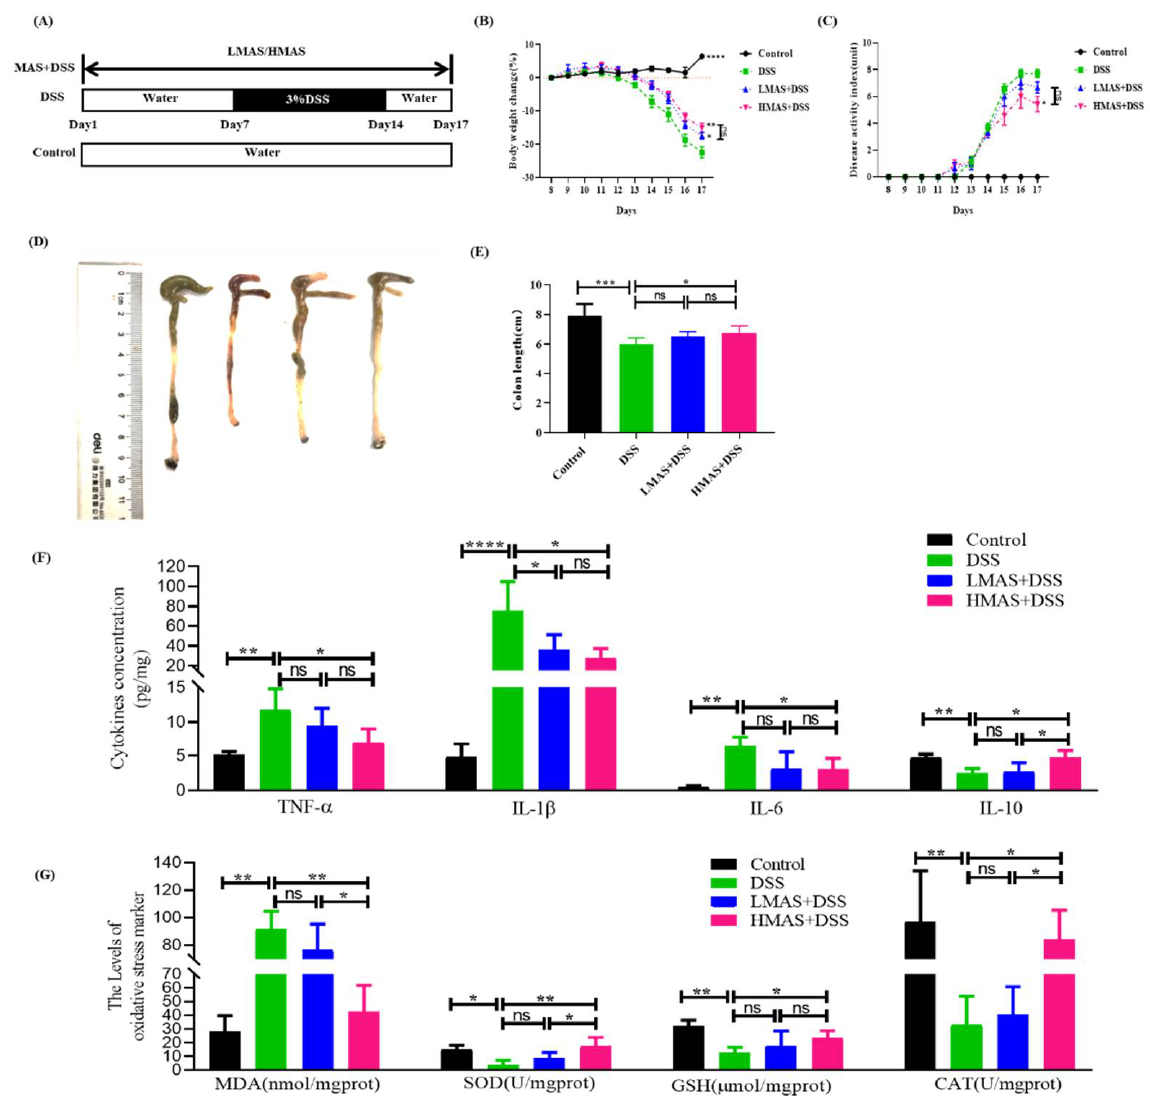
Figure 2. MAS attenuates DSS-induced damage. ( A ) Schematic of experimental design. ( B ) Changes of body weight. ( C ) DAI score. ( D ) Length of experimental mice colon. ( E ) Representative photograph of colons. ( F ) The inflammatory TNF- α , IL-1 β , IL-6, and anti-inflammatory cytokine IL-10 levels. ( G ) The levels of oxidative stress markers (MDA, SOD, GSH, and CAT). Here, ns = not significant. Data were expressed as mean ± SD. * p < 0.05, ** p < 0.01, *** p < 0.001, **** p < 0.0001, in comparison with the DSS group (n = 10).